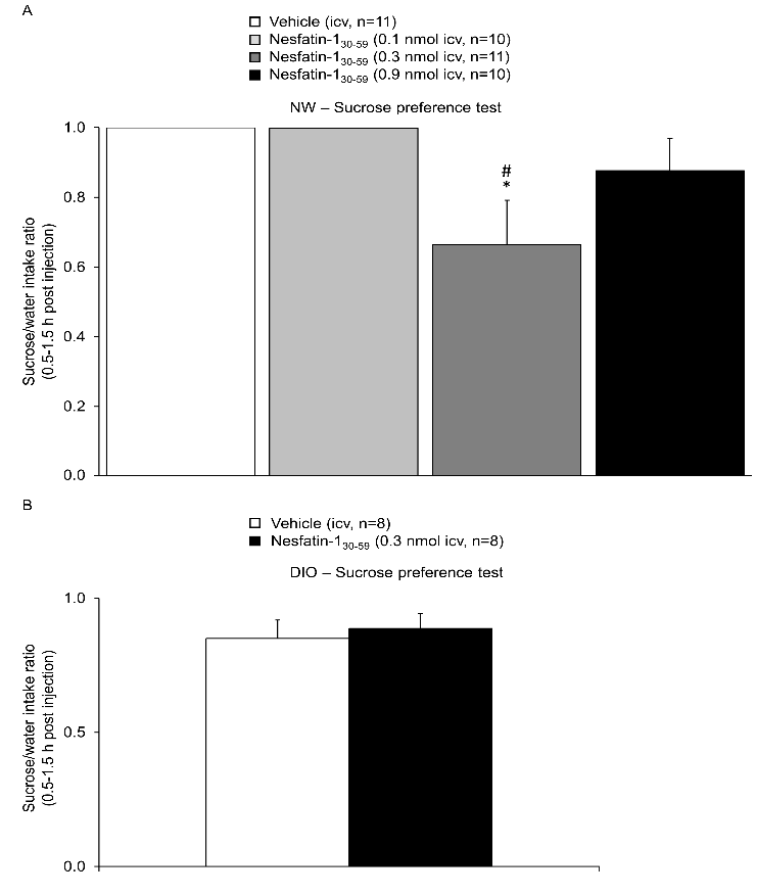
Figure 1. Nesfatin-1 30-59 decreased sucrose preference in normal weight but not in diet-induced obese rats. ( A ) Intracerebroventricularly cannulated normal weight rats were injected with vehicle (5 µ L H 2 O, n = 11) or nesfatin-1 30-59 (0.1 nmol/rat, n = 10, 0.3 nmol/rat, n = 11, or 0.9 nmol/rat, n = 10, in 5 µ L H 2 O) at the beginning of the dark phase and water as well as sucrose intake assessed between 0.5 and 1.5 h post injection. Nesfatin-1 30-59 reduced the sucrose/water intake ratio at a dose of 0.3 nmol/rat; this dose was used for all further analyses. ( B ) Diet-induced obese rats injected with nesfatin-1 30-59 (0.3 nmol/rat in 5 µ L H 2 O, n = 8) did not show significant differences in sucrose preference compared to diet-induced obese rats injected with vehicle (5 µ L H 2 O, n = 8). Data were not normally distributed, for better comparability all data are expressed as mean ± SEM. Data were analyzed using one way ANOVA ( A ) or Mann–Whitney-U test ( B ). Abbreviations: DIO, diet-induced obesity; NW, normal weight. * p < 0.05 vs. vehicle; # p < 0.05 vs. Nesfatin-1 30-59 0.1